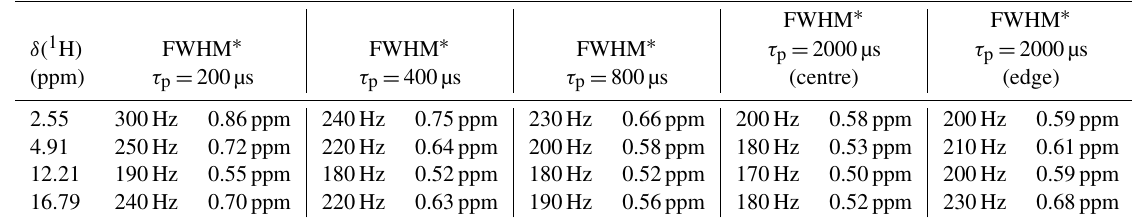
Table 2. Full width at half maximum (FWHM) for homonuclear decoupled proton spectra of L-histidine at 600MHz shown in Fig. 8.